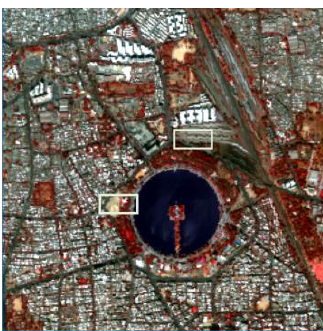
Figure 4. Location of Patches for Visual Examination